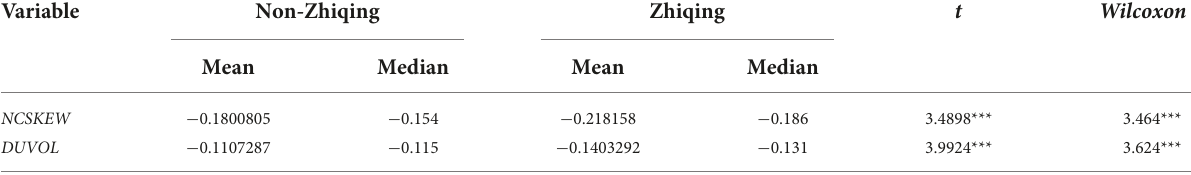
TABLE 4 Univariate analysis (Zhiqing vs.